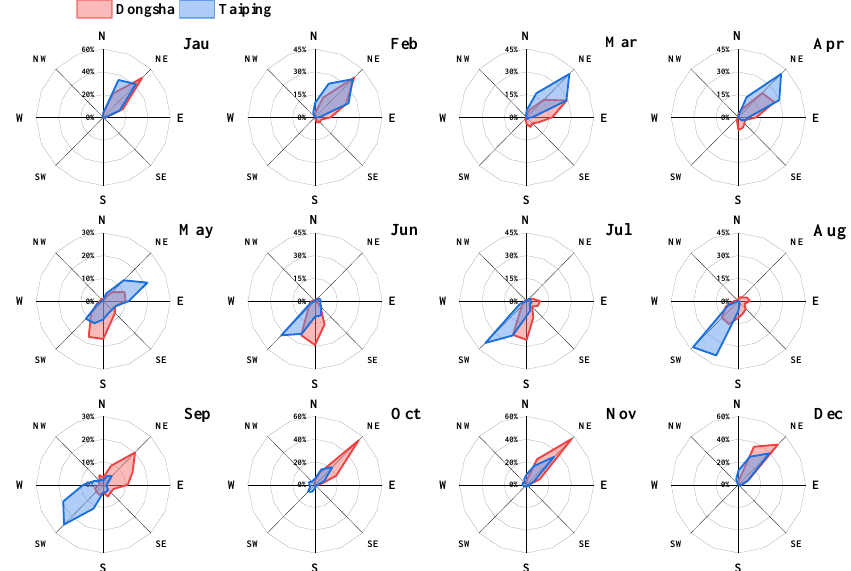
Figure 11. Monthly wind rose graphics obtained at Dongsha and Taiping island for three years.